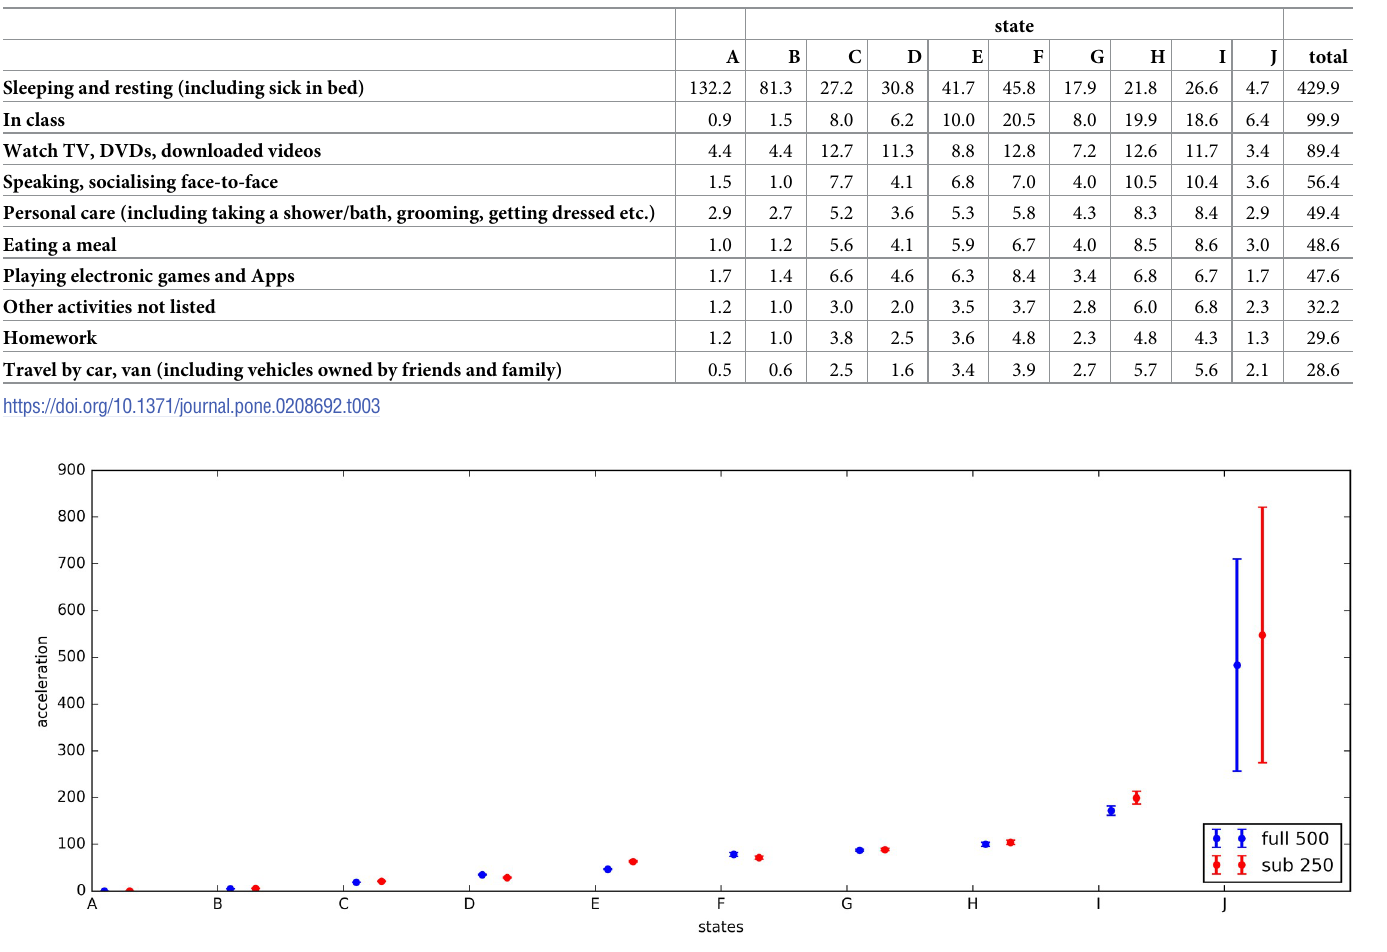
Fig 6. Mean and variance parameters for acceleration.